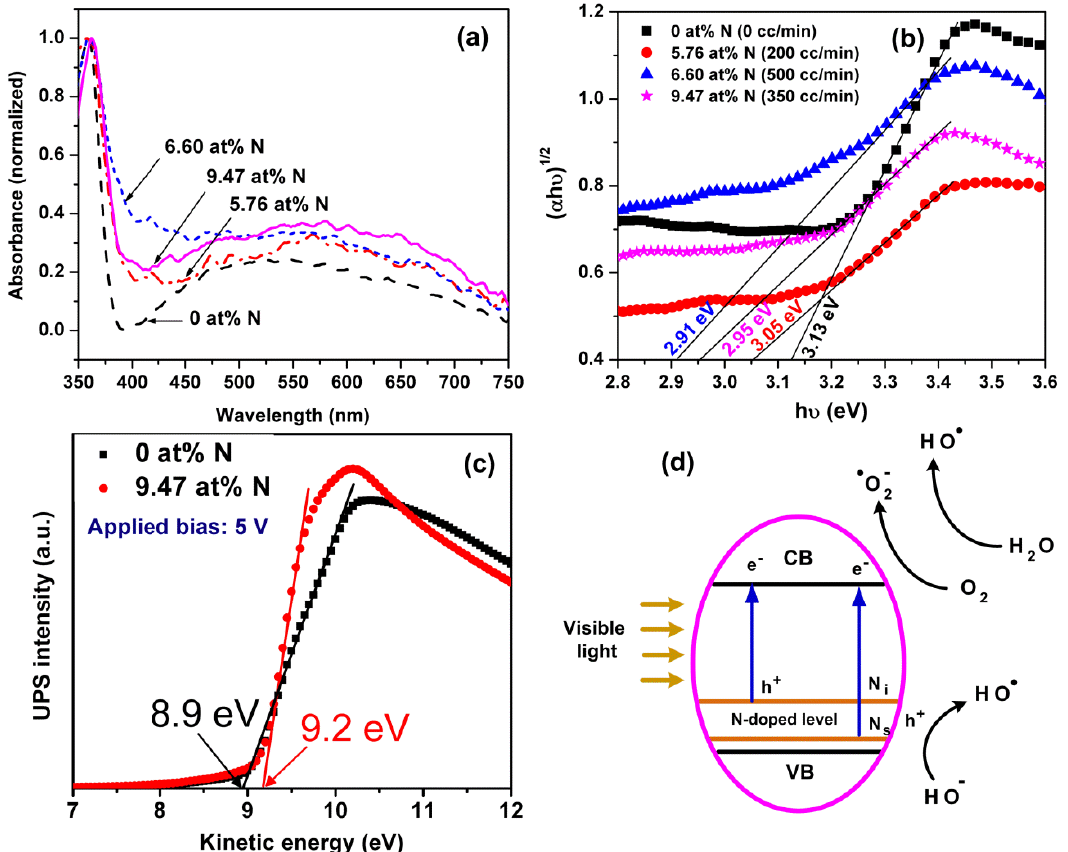
Figure 4. ( a ) UV-Vis absorption spectra of pristine TNAs and N-TNAs with various N-doping levels. ( b ) Plot of ( αhν ) 1/2 vs. hν of the samples. ( c ) UPS spectroscopy of pristine TNAs and N (9.47 at %)-TNAs, ( d ) the schematic band diagram of N-TNAs.